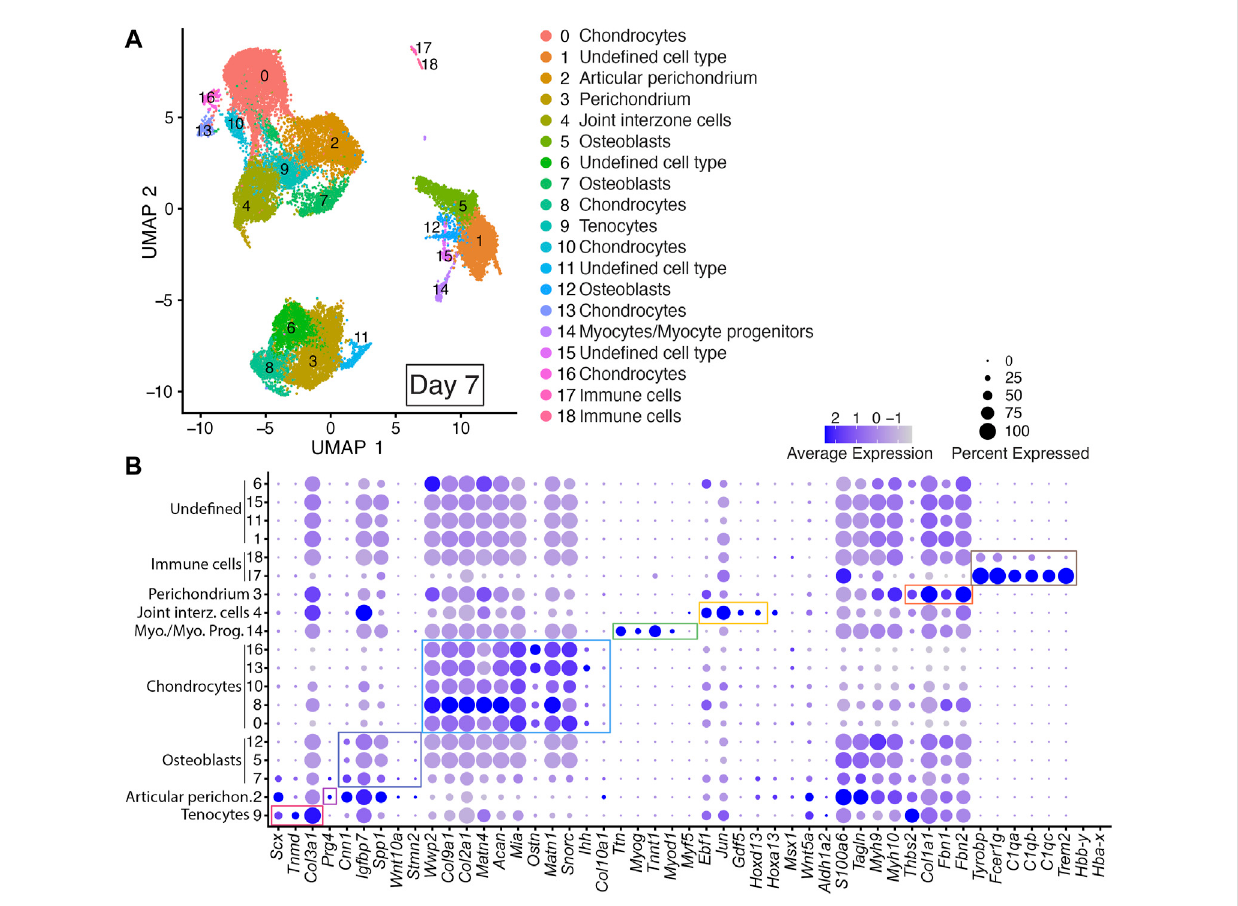
FIGURE 4 scRNAseq analysis of Day 7 in vitro cultures identi fi es multiple early autopod cell types. (A) UMAP (Uniform Manifold Approximation and Projection) plot of Day 7 culture scRNAseq results demonstrate 19 different clusters of identi fi able cell populations. Individual cells are color coded based on cluster andmarkergeneannotationdenotingtenocytes(Cluster9),articularperichondrium(Cluster2),osteoblasts(Clusters5,7and12),chondrocytes(Clusters 0, 8, 10, 13, and 16), myocytes/myocyte progenitors (Cluster 14), joint interzone cells (Cluster 4), perichondrium (Cluster 3), immune cell lineages (Clusters 17and18)andunde fi nedcell types(Clusters1,6,11,and 15). (B) Dotplots highlighting expressionpro fi lesofselected markergenespercell type used for cluster cell identi fi cation. Colored rectangles highlight the subset of markers used to identify tenocytes (red), articular perichondrium (pink), osteoblasts(purple),chondrocytes(blue),myocytes/myocyteprogenitors(green),jointinterzonecells(yellow),perichondrium(orange),andimmunecell lineages (brown). Dot diameter corresponds to the percentage of cells expressing the gene in each cluster. High-Low expression is denoted by Purple- Gray bar,